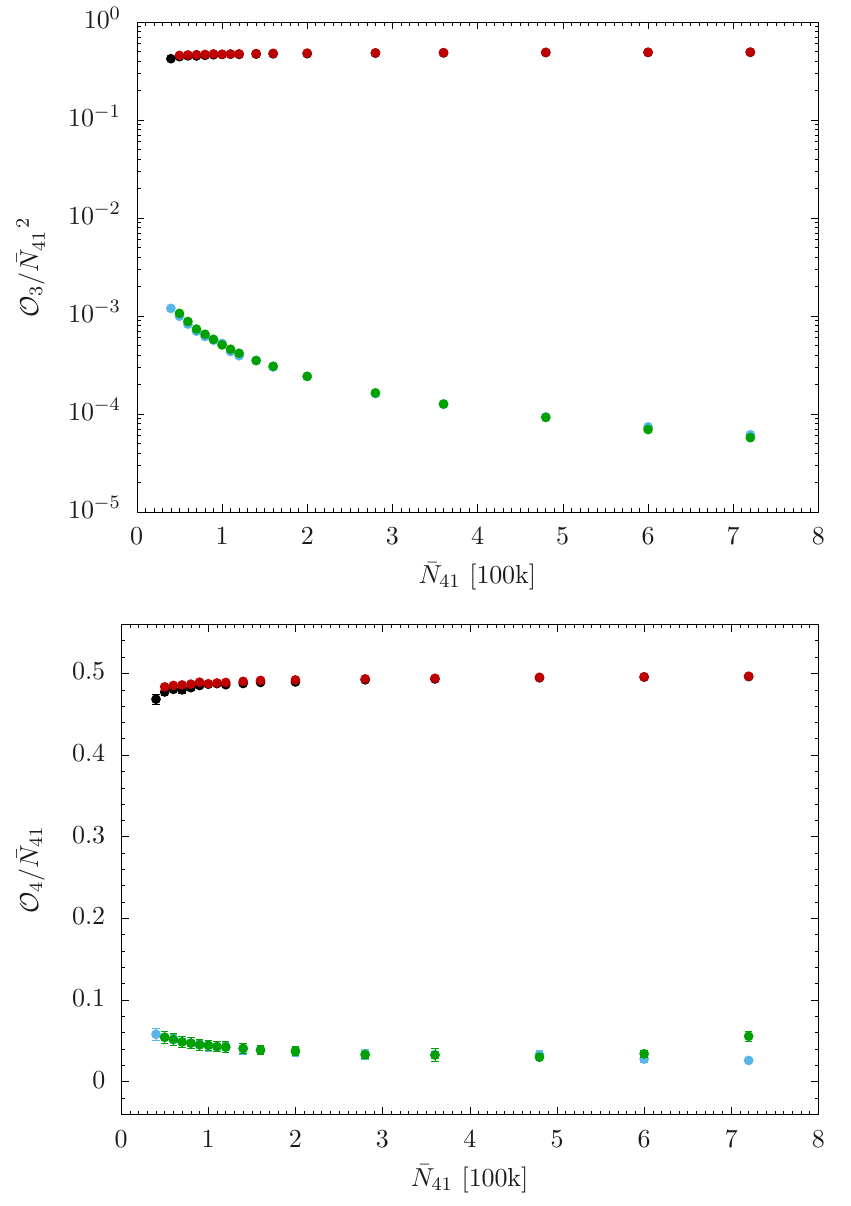
Figure 7 . The order-parameters O 3 = (cid:22) N 2 hysteresis. The colors correspond to the convention used in (cid:12)gure 2.